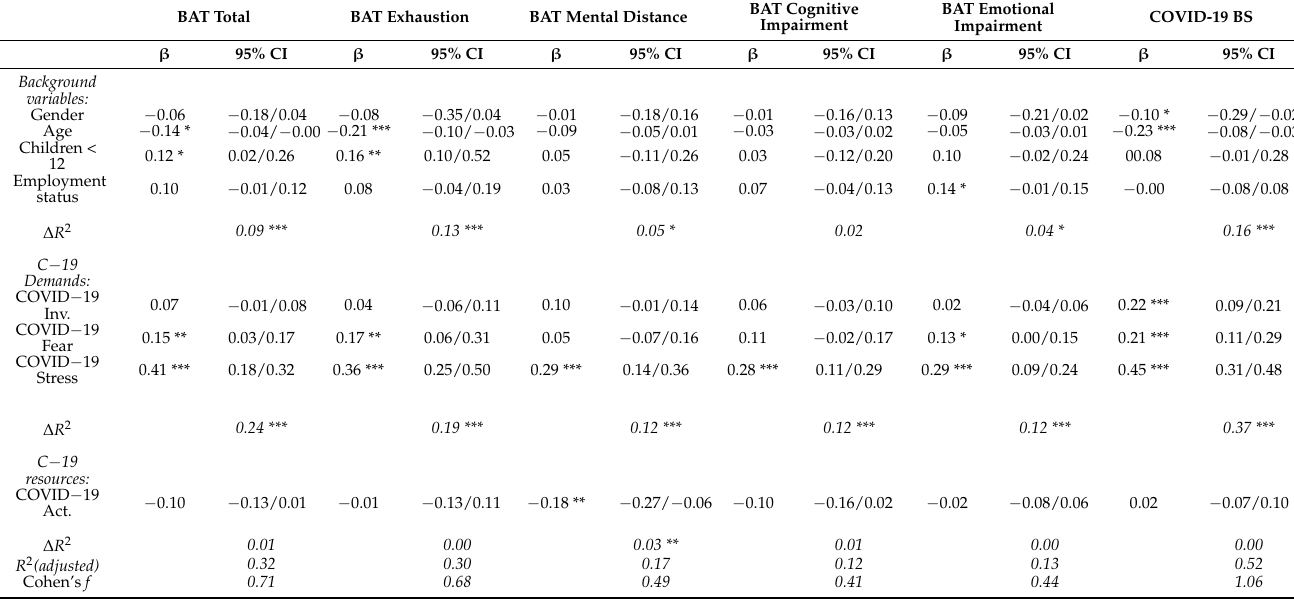
Table 3. Linear regression analyses for the situational (COVID-19) factors on the different burnout measures (BAT and COVID-19-BS).